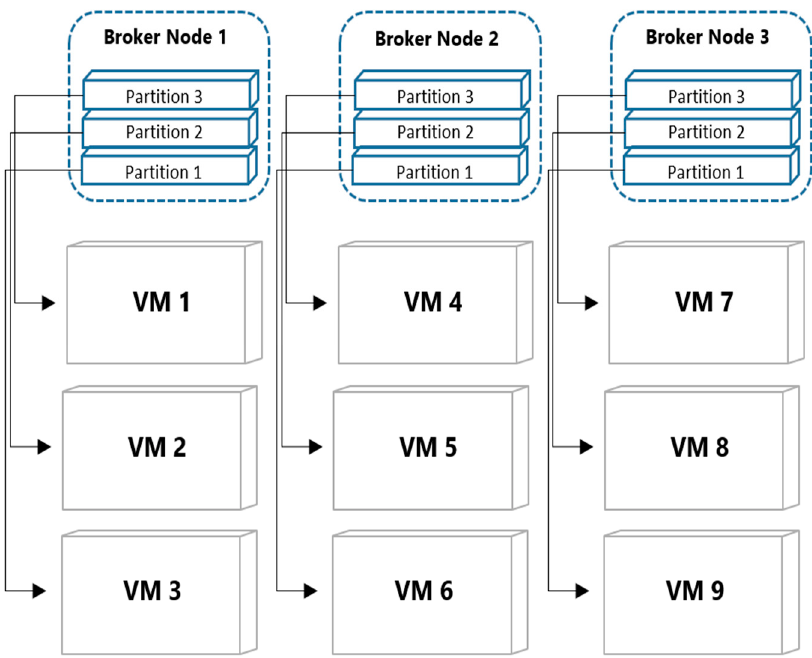
Figure 4. The example case of distributed environment consisting of 3 broker nodes and 9 VMs.